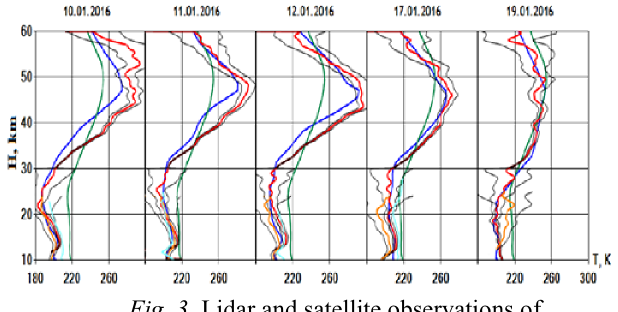
Fig.2 Time series of integrated aerosol backscattering coefficient for the period of 2016 – 2018.